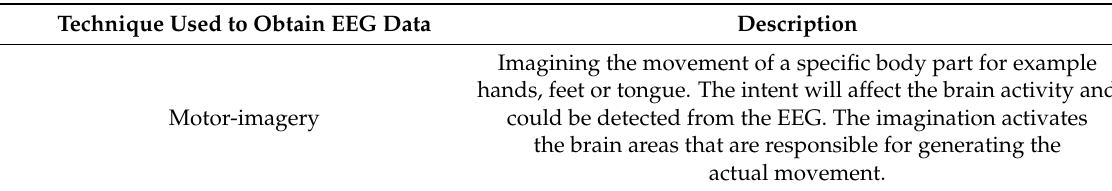
Table 1. Categorization of BCIs and corresponding techniques used to obtain EEG data according to Al-Nafjan et al. [5] and Abiri et al.